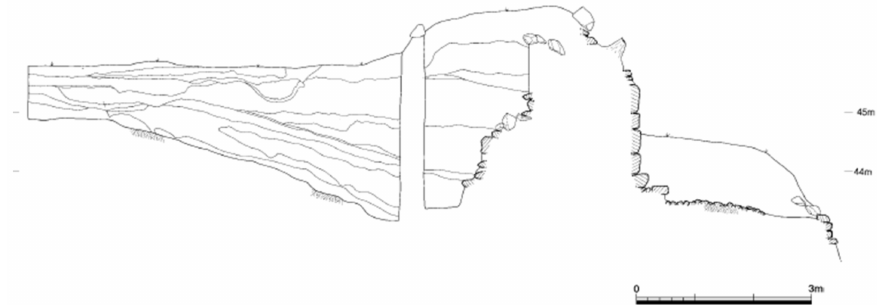
Figure 6. Cross section of Choru Dondae. Reprinted with permission from Ref. [33]. 2004, National Research Institute of Cultural